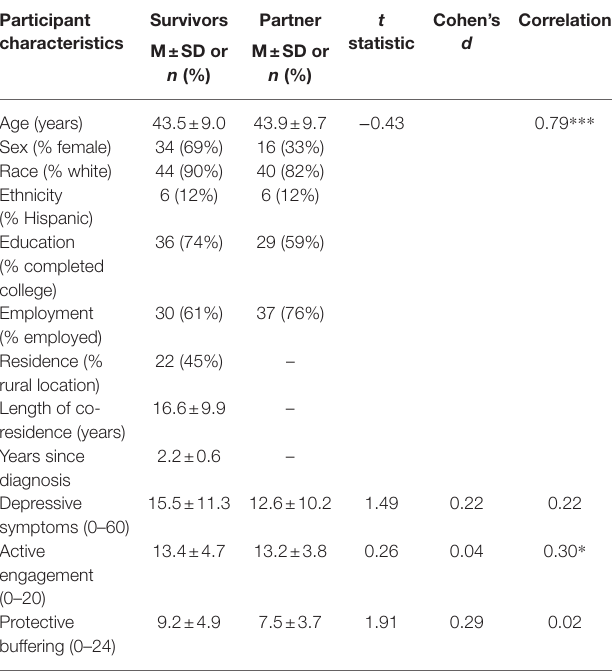
Differences between survivors and partners were examined using paired t-tests. Correlations represent paired samples correlations between survivors and partners. * p < 0.05 and *** p <